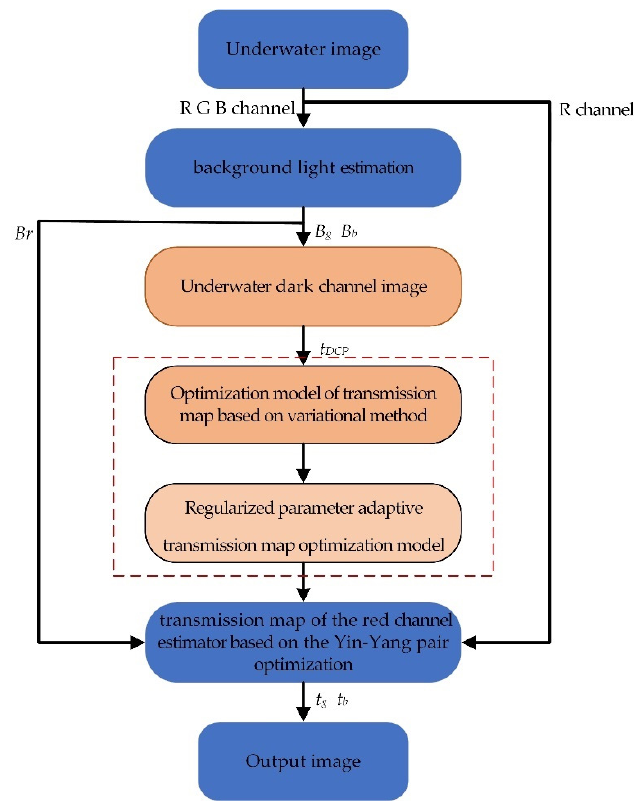
Figure 4. Framework of the proposed approach.